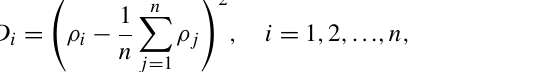
projection. As the MCD43A4 NBAR is corrected for view- angle effects and Landsat has a small view angle of ± 7 . 5 ◦ , the view-angle difference between MCD43A4 and Landsat SR could be considered